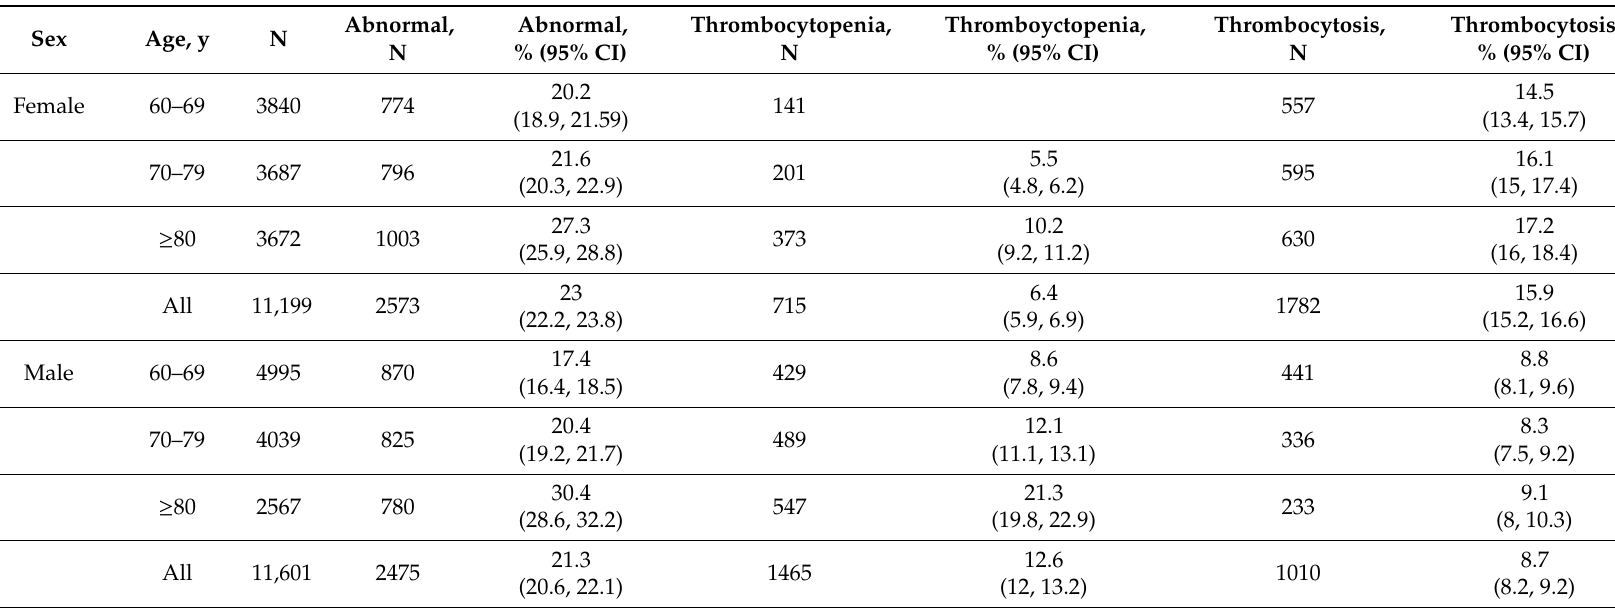
Table 4. Frequencies of abnormal platelet counts in a population-based setting in the Principality of Liechtenstein using the conventional reference limit (150–350 × 10 9 / L).